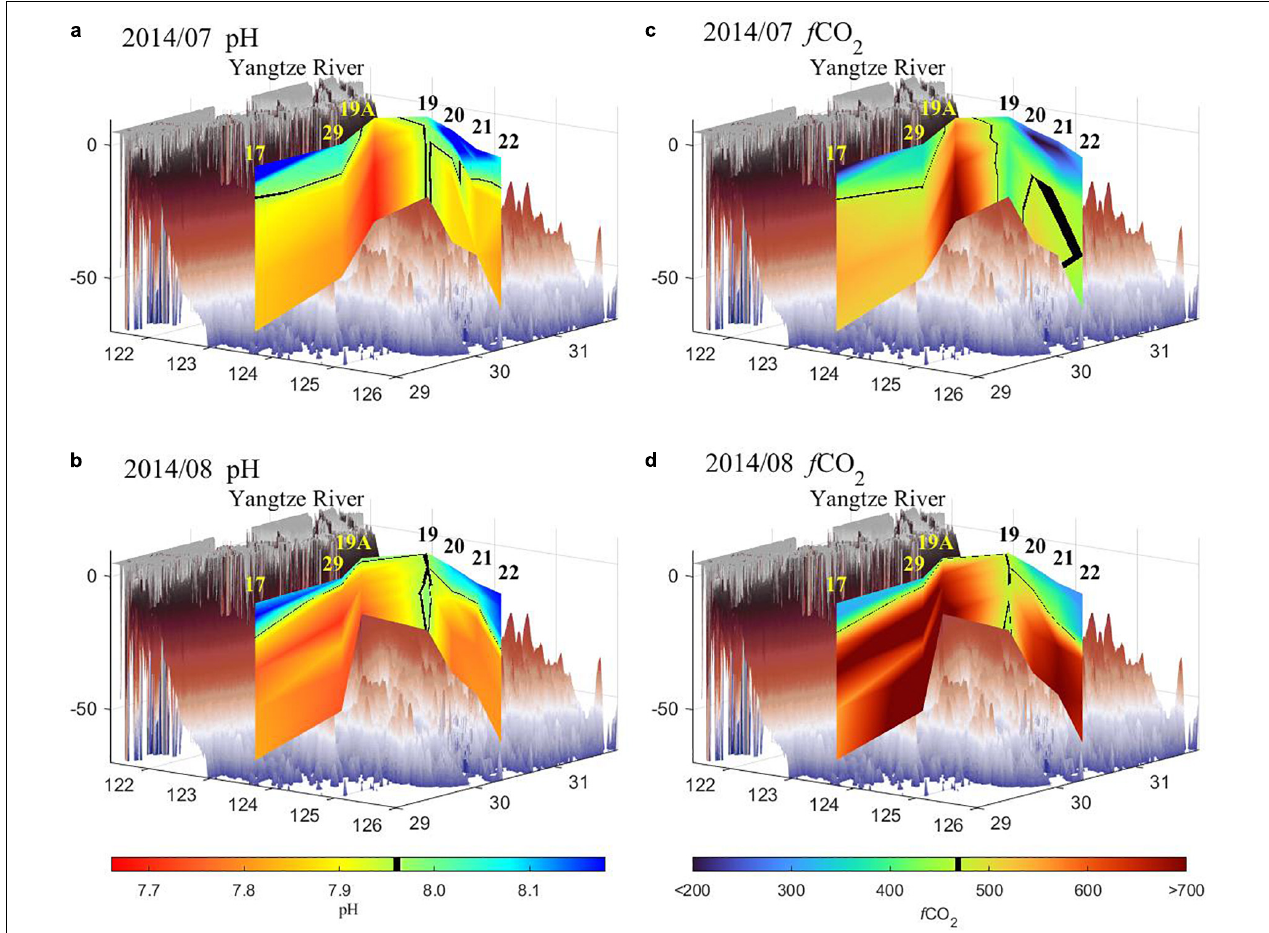
FIGURE 7 | Depth profiles of pH and fugacity of CO 2 ( f CO 2 ) at sampling stations off the Changjiang River estuary along northern-most transect line (e.g., St. 19, 20, 21, and 22) and near-coast transect line (e.g., Sts. 19, 19A, 29, and 17) in July (a,c) and August (b,d) 2014. For reference, the values of f CO 2 = 468–471 µ atm and pH = 4.96 were marked in black. The bathymetry/elevation data retrieved from GEBCO (https://www.gebco.net/data_and_products/gridded_bathymetry_data/). Please refer to Figure 1 for